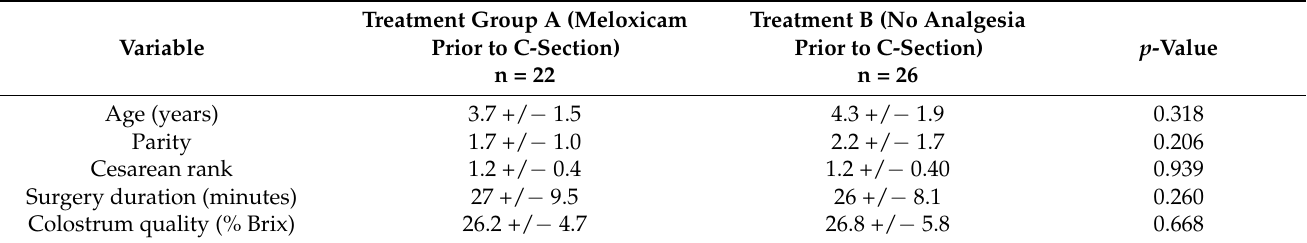
Table 1. Description (mean and standard deviation) of the study sample according to treatment group.